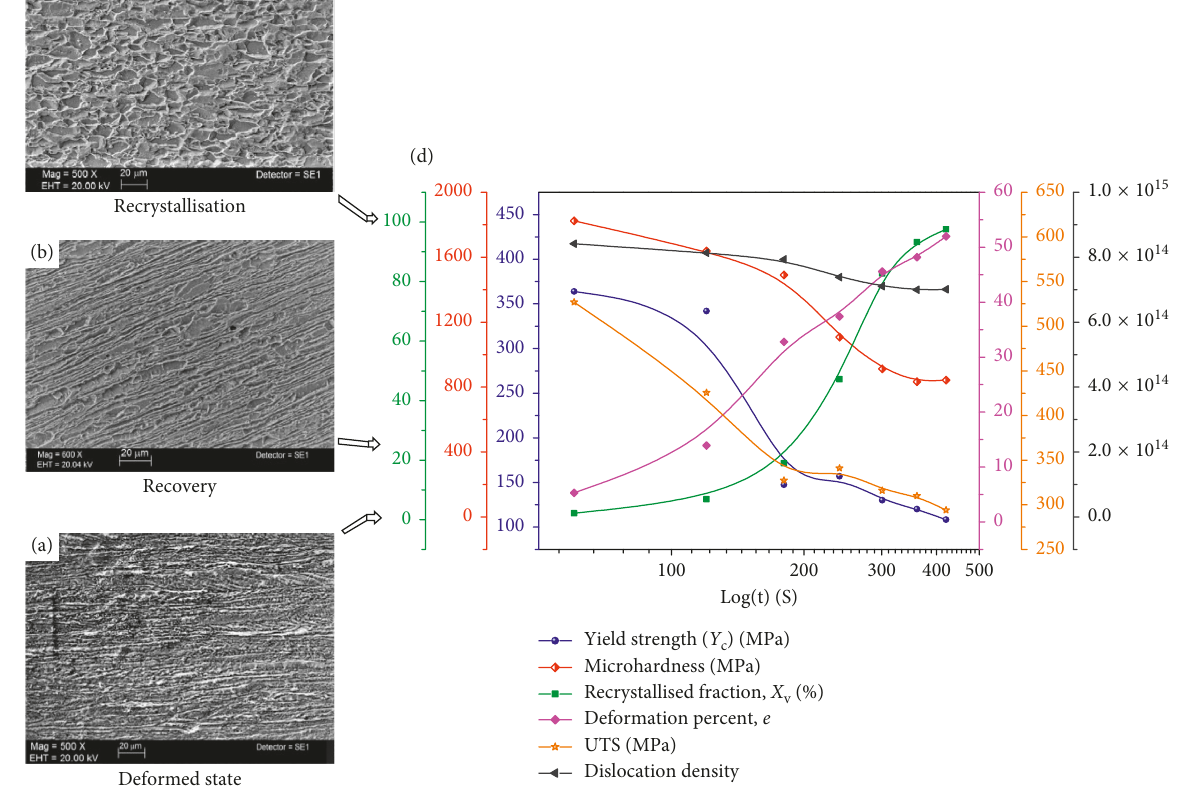
Figure 5: Model of the recrystallisation behaviour including the evolution of the microstructure and mechanical properties as functions of annealing time and the recrystallised fraction of IF